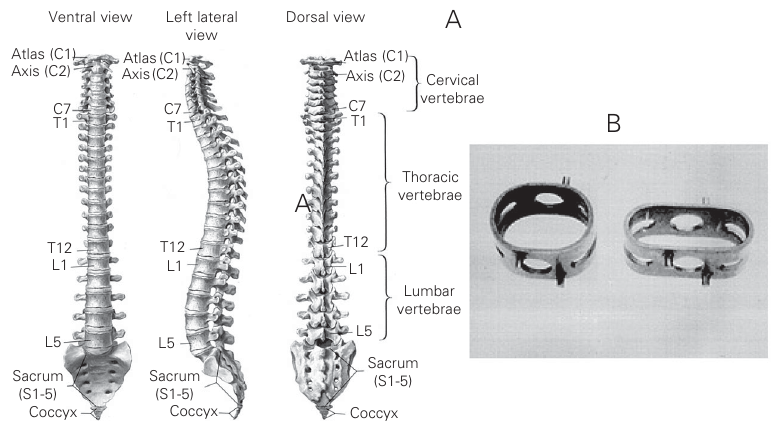
Figure 8. Spinal vertebrae (A) and shape memory spacers (B) in the martensitic state (left) and in the original shape (right). Taken from Ref. 20 with permission.